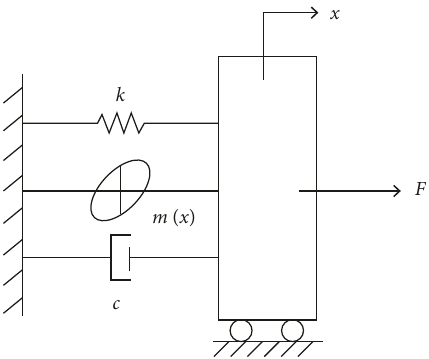
Figure 14: Restoring force model of the MRG/MRE isolator. Table 4: Identified parameters under different